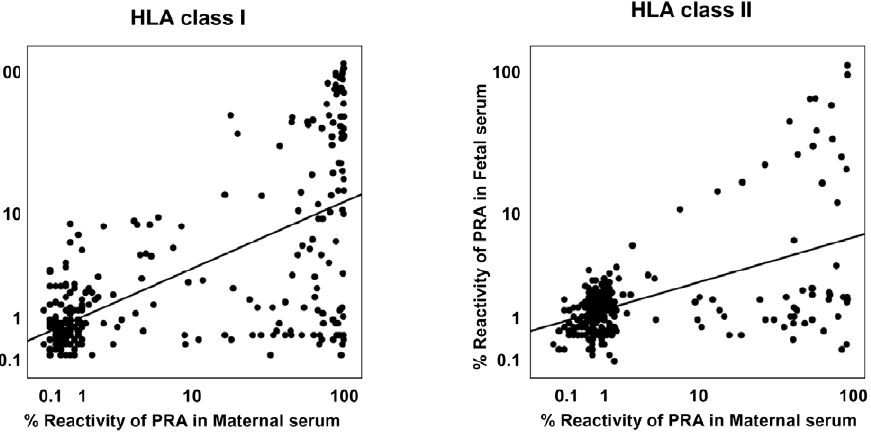
Figure 4. Correlation between maternal and fetal anti-HLA class I and class II antibodies. The panel reactivity of maternal anti-HLA antibodies is associated with that of fetal anti-HLA antibodies (for anti-HLA class I antibodies: r=0.578, p , 0.001; for anti-HLA class II antibodies: r=0.358, p , 0.001). PRA , panel-reactive anti-HLA antibodies. doi:10.1371/journal.pone.0016806.g004 PLoS ONE |